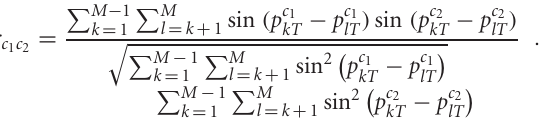
condition, represented by p -value averaged across all partici- pants (uncorrected for multiple comparison with electrodes). An increase of EEG power was found at theta range of 7.1–8.5 Hz,